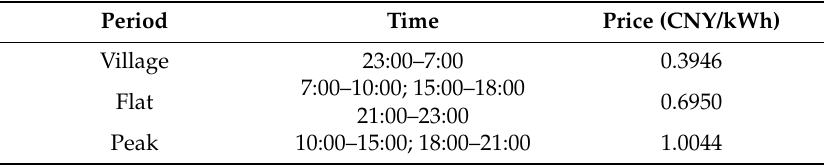
Table 9. Time-of-use (TOU) electricity price.